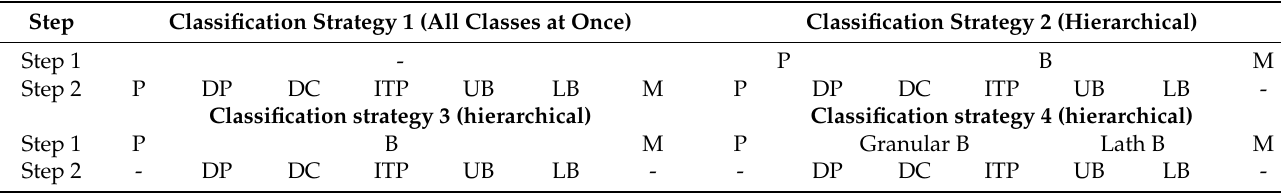
Table 2. Overview of classification